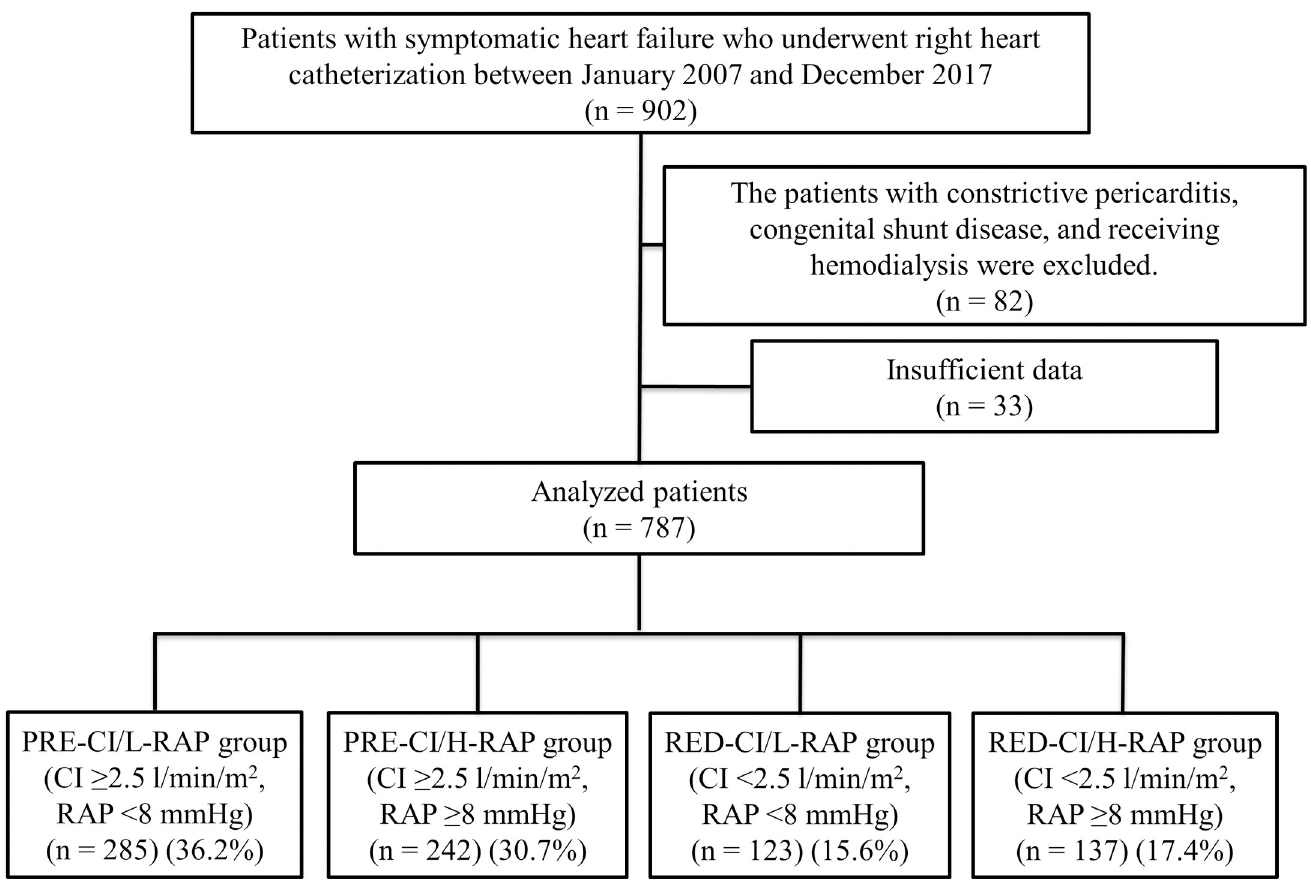
Fig 1. Patient enrollment. CI, cardiac index; RAP, right atrial